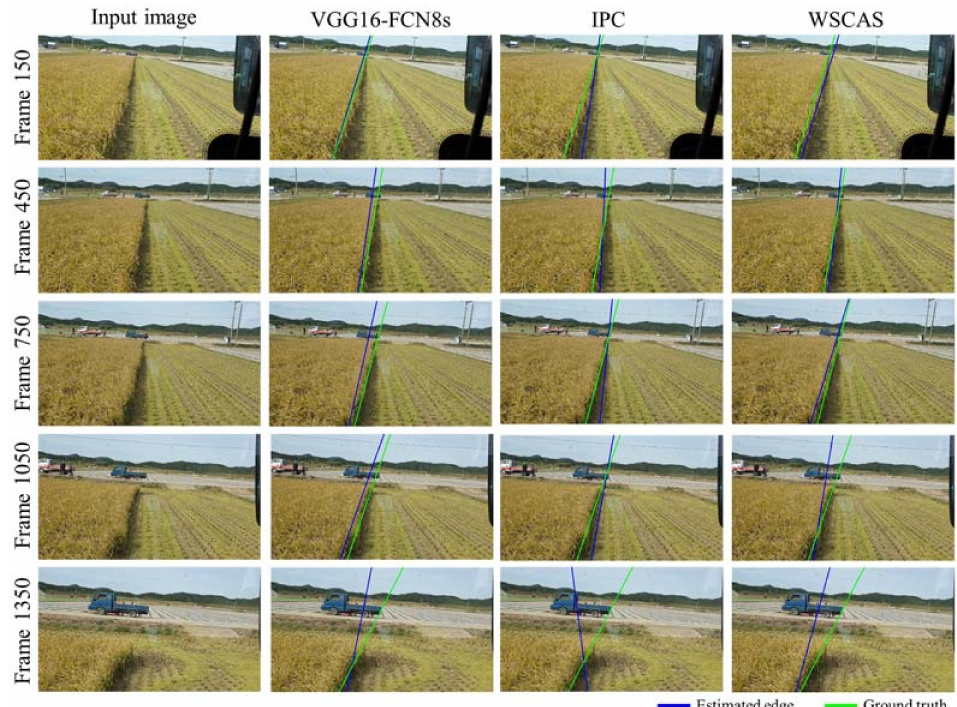
Figure 7. Representative results of edge detection for several frames that have 300 regular intervals from the top to the bottom row. Each row consists of 4 images: the input image and the segmentation results via VGG16-FCN8s, IPC, and WSCAS from left to right.